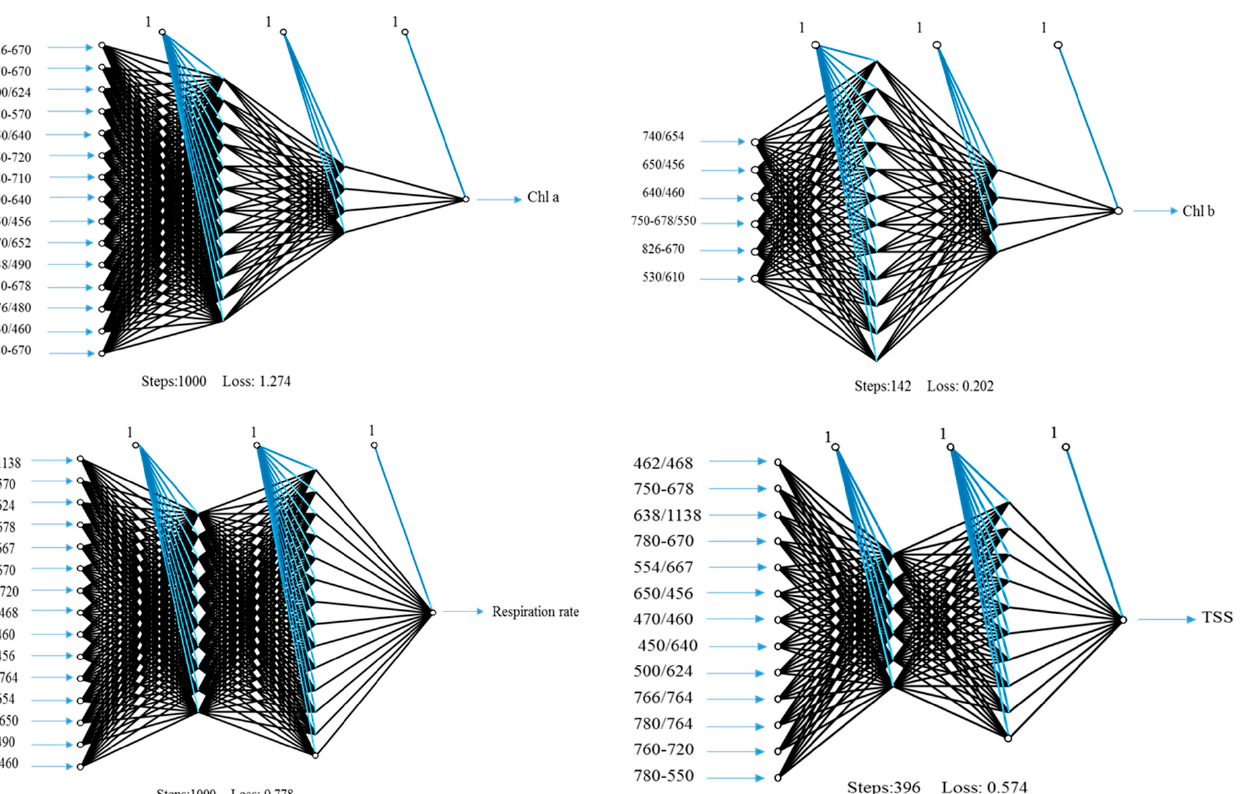
Figure 3. Neural network diagrams were established for detecting Chl a, Chl b, respiration rate, TSS, and firmness of banana fruits.